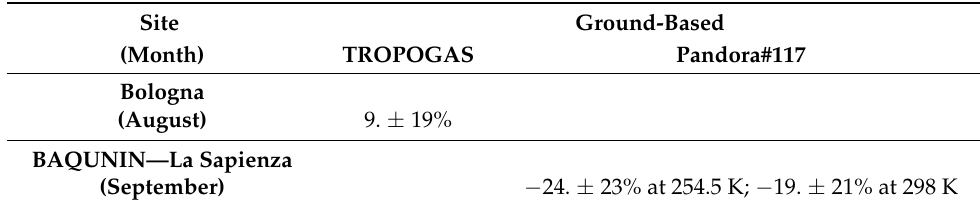
Table 1. Relative bias and spread in NO 2 total VCDs retrieved from SkySpec-2D- versus ground- based instruments for different